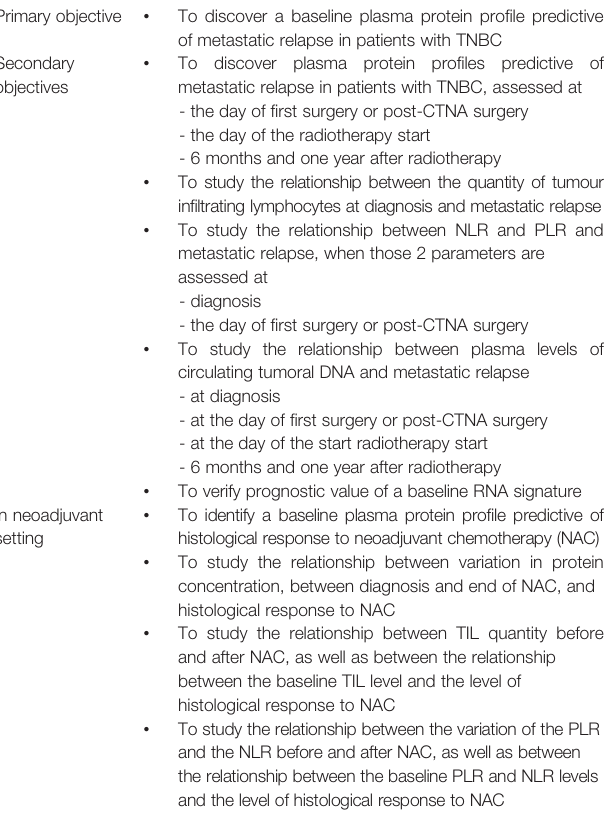
TABLE 1 | Primary and secondary